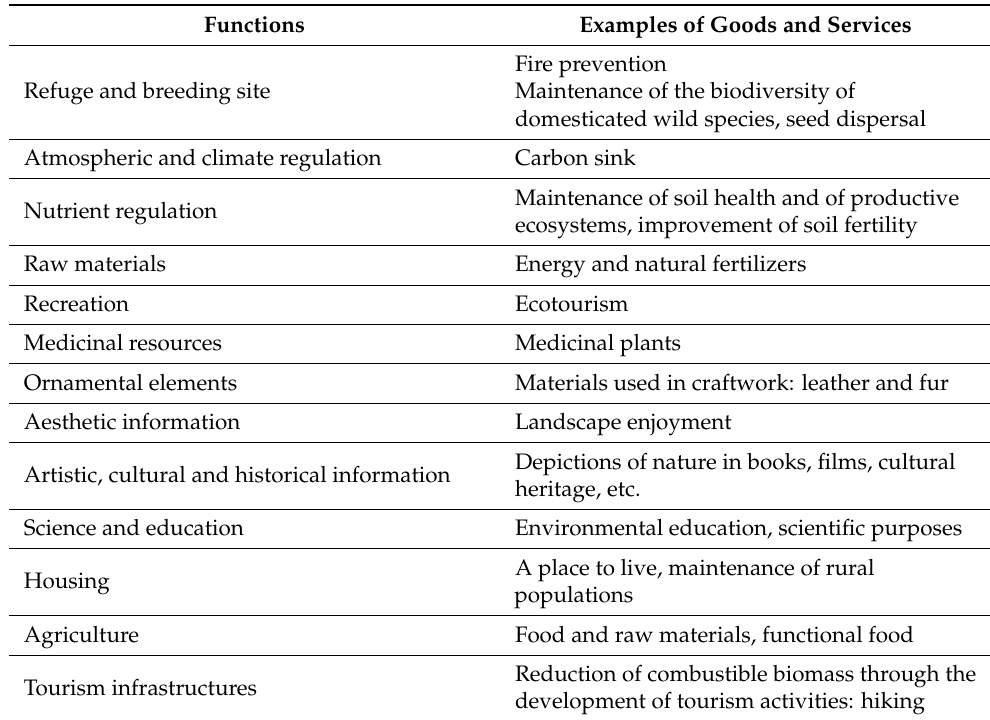
Table 3. Ecosystem functions, goods and services associated with pastoral husbandry. From G ó mez- Baggethun and De Groot